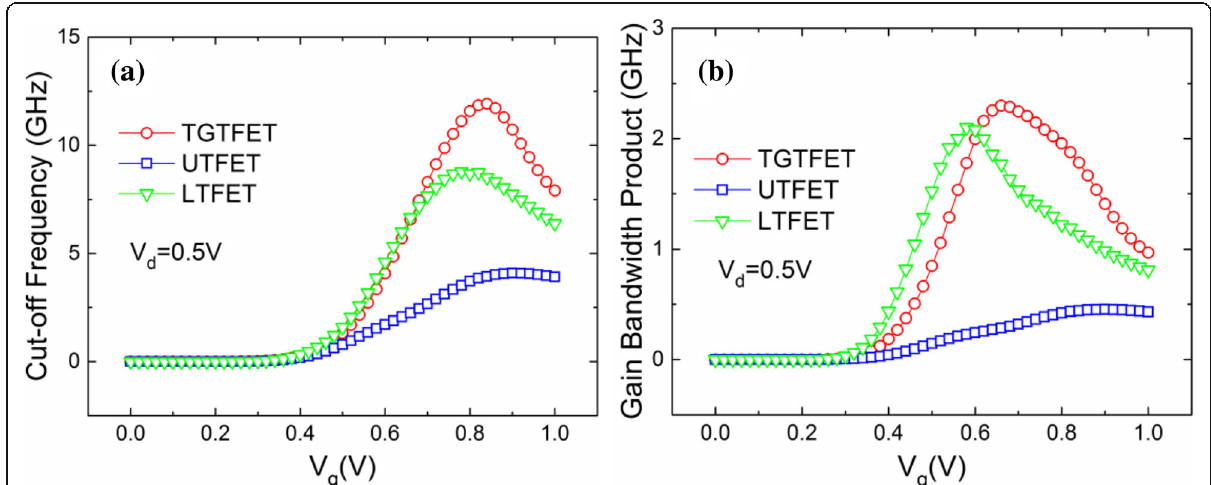
Fig. 16 The characteristic curves of a f T and b GBW of TGTFET, UTFET, and LTFET versus V g at V d = 0.5